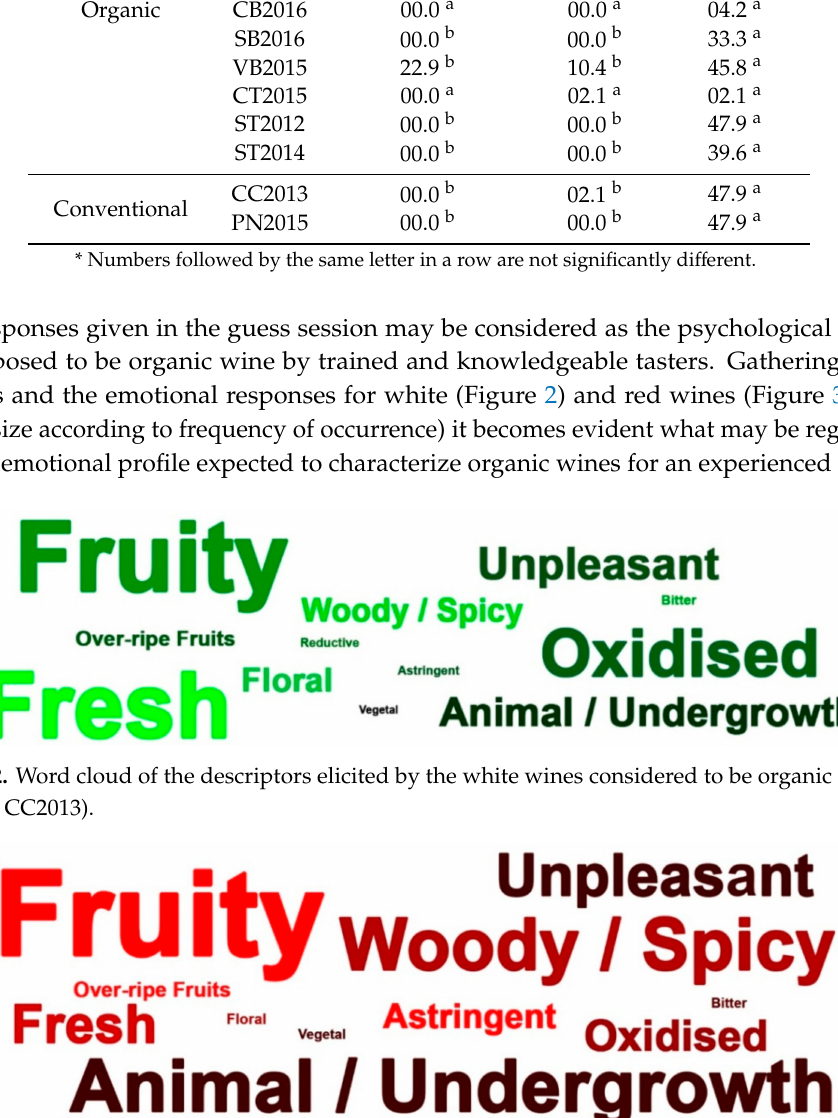
Figure 3. Word cloud of the descriptors elicited by the red wines considered to be organic (ST2012, ST2014,